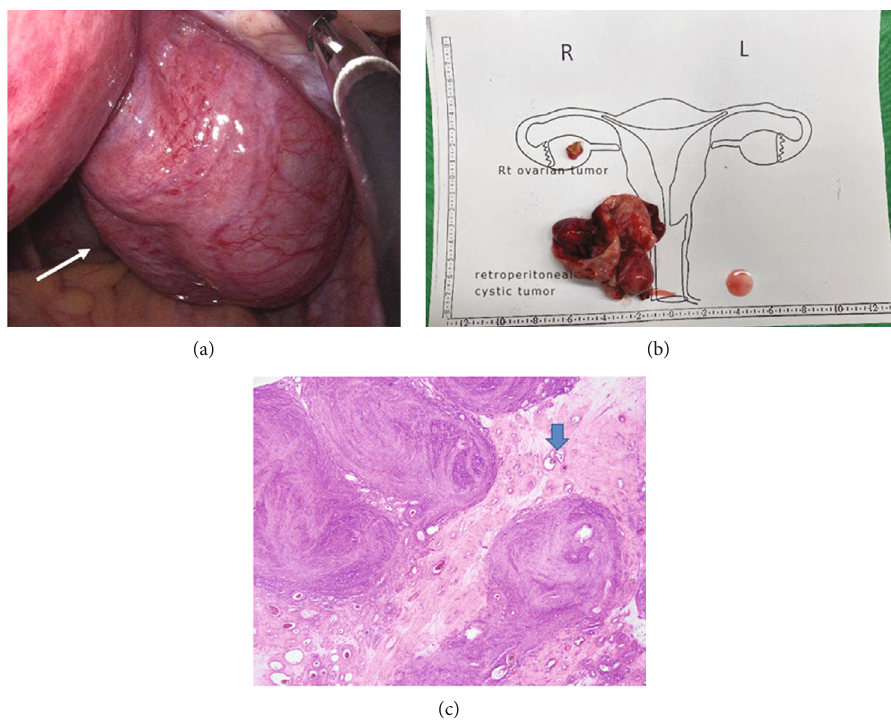
Figure 3: Laparoscopic view, gross, and microscopic picture of the tumor. (a) During the surgery, a retroperitoneal cystic tumor measuring 8 × 4cm was found located in the right pelvic cavity (arrow). (b) The tumor was grayish-white and grossly elastic. (c) Microscopically, the tumor revealed leiomyoma with infarction and cystic degeneration